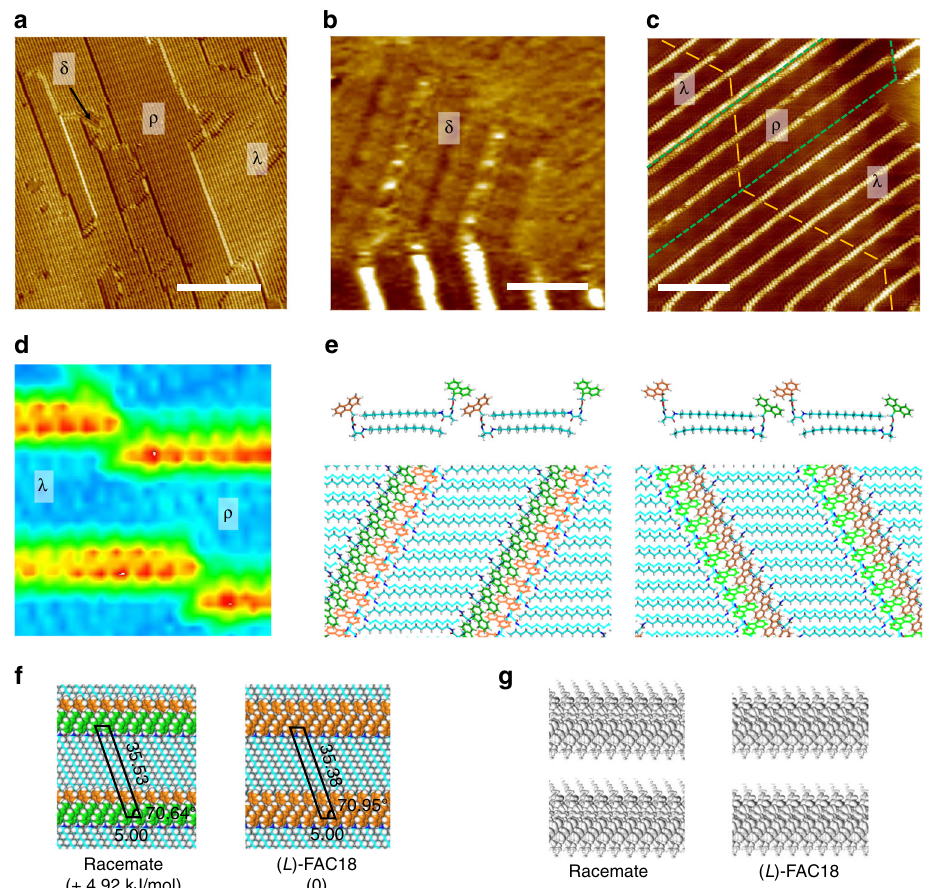
Fig. 5 Various phases of the racemate. a Large-scale STM image of the lamellar structure formed from the equimolar mixture of ( L )-FAC18 and ( D )-FAC18, where three types of domains ( λ , ρ , and δ ) can be identi fi ed according to their brightness and pattern. I set = 150 pA, V bias = − 800 mV. b STM image showing a small patch of the δ phase ( I set = 20 pA, V bias = − 600 mV). c STM image showing the coexistence of λ and ρ domains. I set = 200 pA, V bias = − 600 mV. The yellow lines indicate the orientation of alkyl chains (see Supplementary Fig. 9 for enlarged image), while the green dashed lines outline the domain boundaries. d Close-up image showing transition in contrast from a λ domain to a ρ domain. e Structural models for the CW and CCW bilayer structure of the racemate, respectively, with dimensions (nm) 0.50 × 3.55, γ = 70°. The fl uorene groups of ( L )-FAC18 and ( D )-FAC18 are displayed in orange and green, respectively. The top and bottom layers are displayed in stick and line representations, respectively. f A comparison between the lattice parameters (in Å) and the energy (displayed in parenthesis) of DFT-optimized CW bilayers of ( L )-FAC18 and the racemate. g HOMO to HOMO-3 isosurfaces of the CW bilayer structures of the racemate and ( L )-FAC18. Scale bars: a 100 nm; b 5 nm; c 10